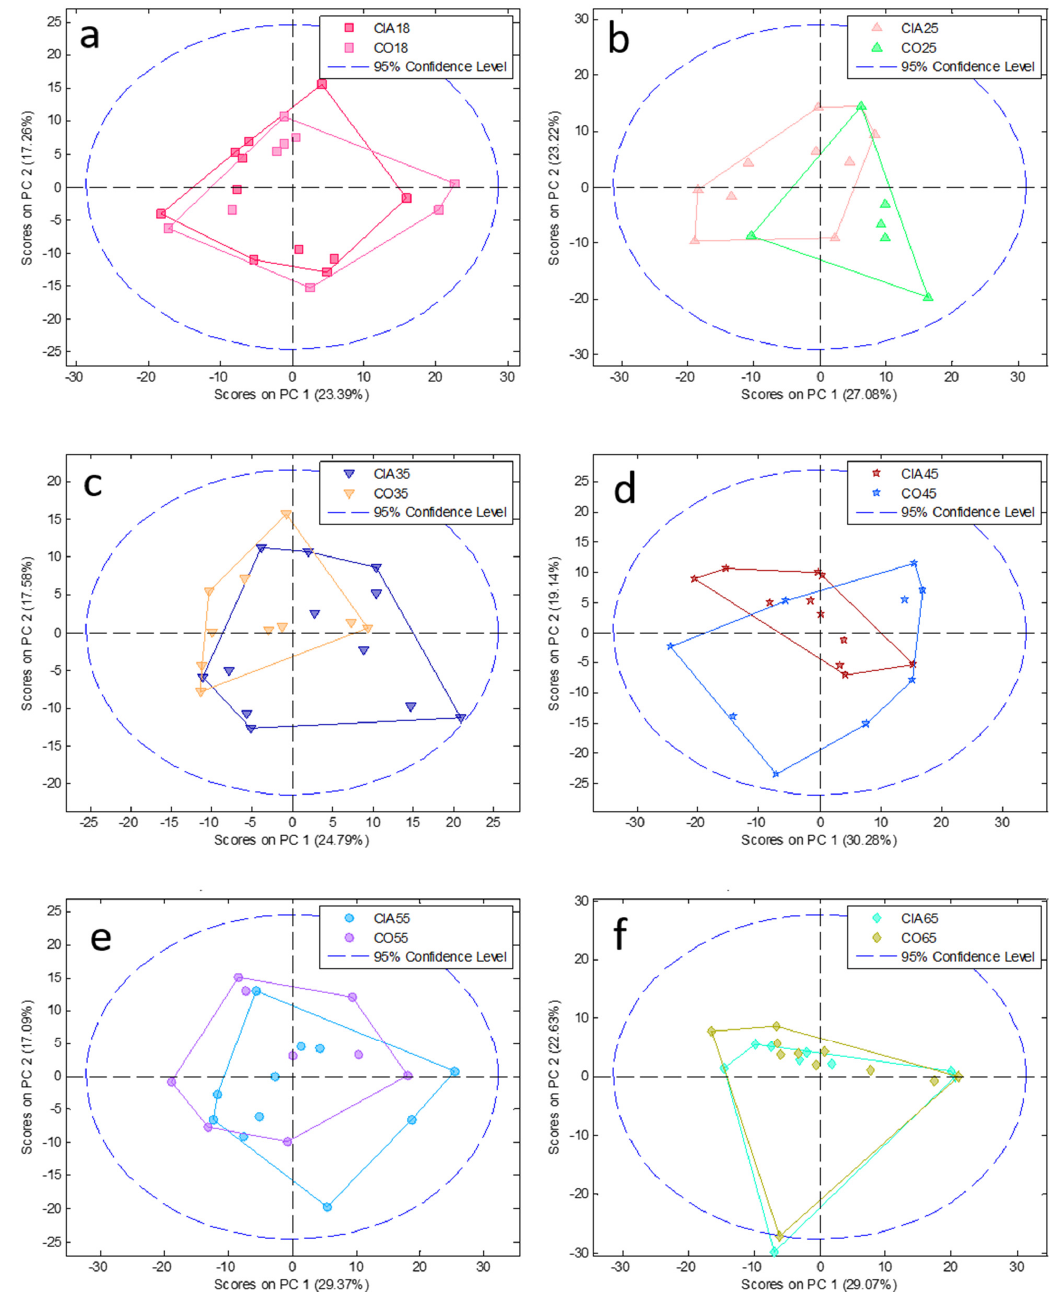
CO45: CO group 45 days after the beginning of the experiment (blue star); CO 55: CO group 55 days after the beginning of the experiment (purple circle); CO65: CO group 65 days after the beginning of the experiment (yellow diamond). PC: principal component; LV: latent variable.